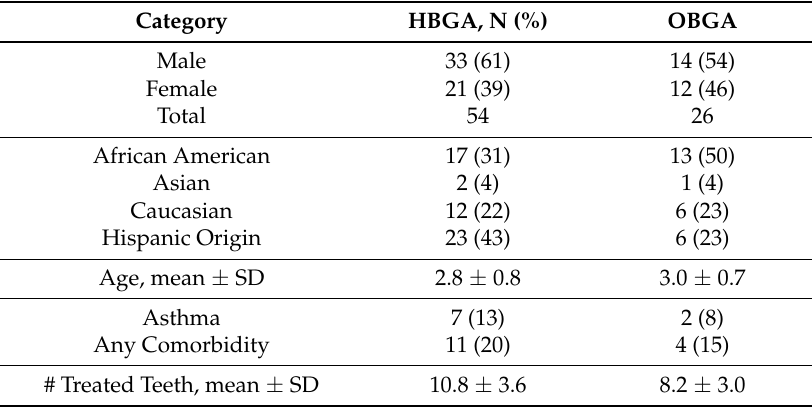
Table 2. Subject characteristics and demographics.